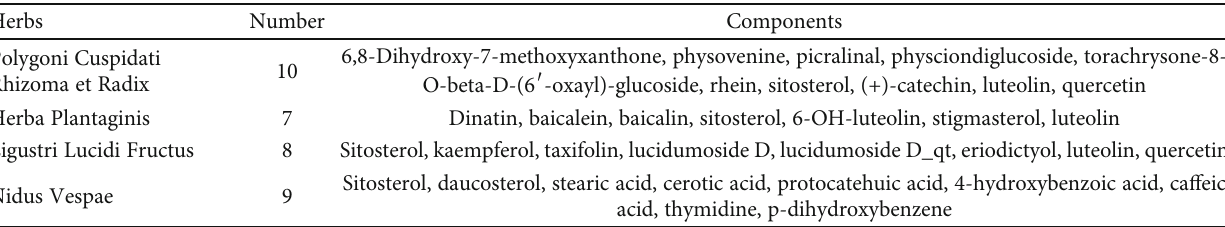
Table 2: Active components identi fi ed from herbs of